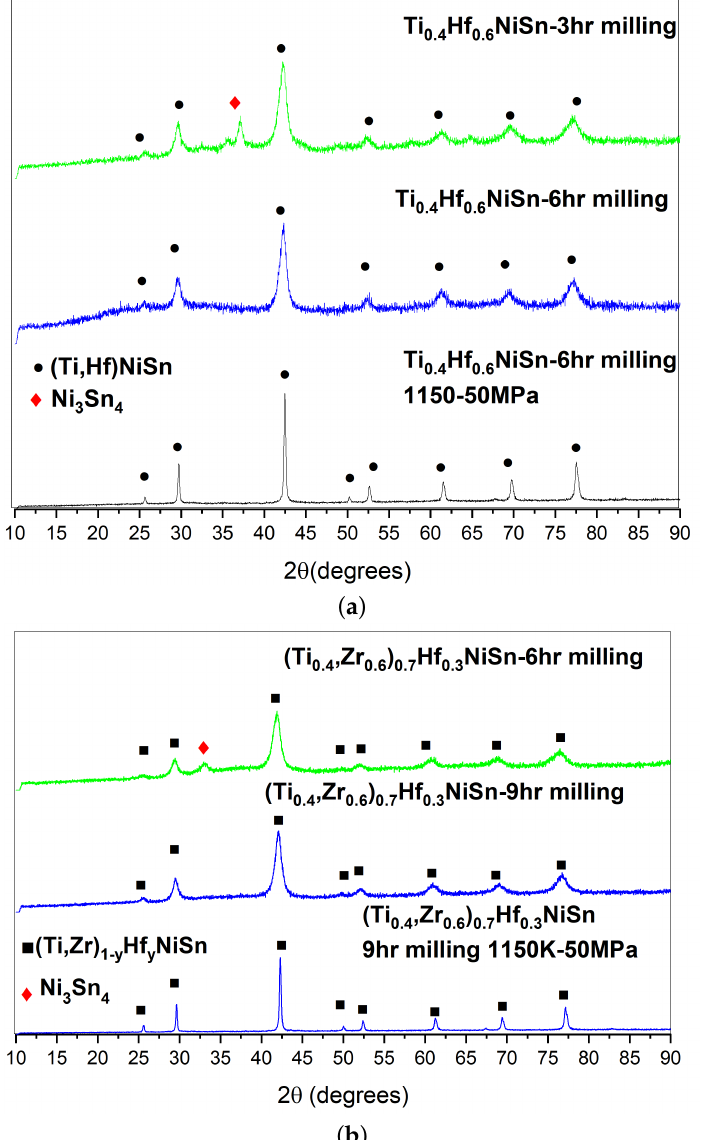
Figure 2. ( a ) PXRD patterns for the synthesis of Ti 0.4 Hf 0.6 NiSn. ( b ) PXRD patterns of the synthesis of (Ti 0.4 Zr 0.6 ) 0.7 Hf 0.3